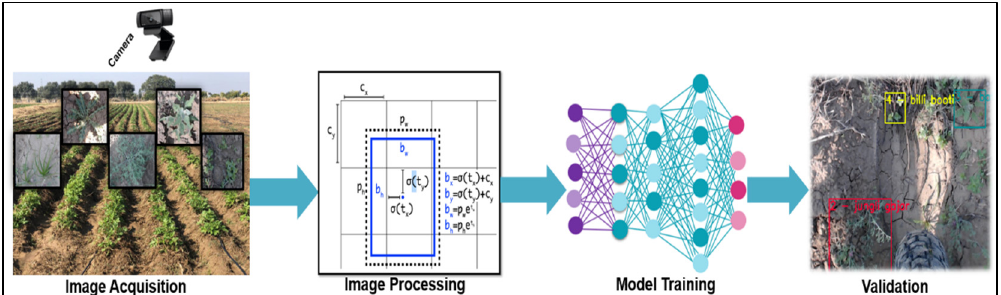
Figure 1. Proposed methodology diagram.